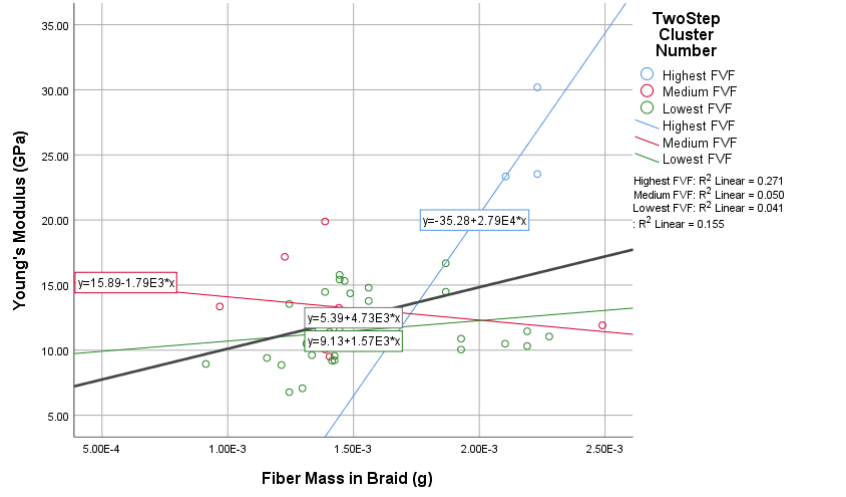
Figure 17. The relationship between fiber mass in the braid’s sheath and Young’s